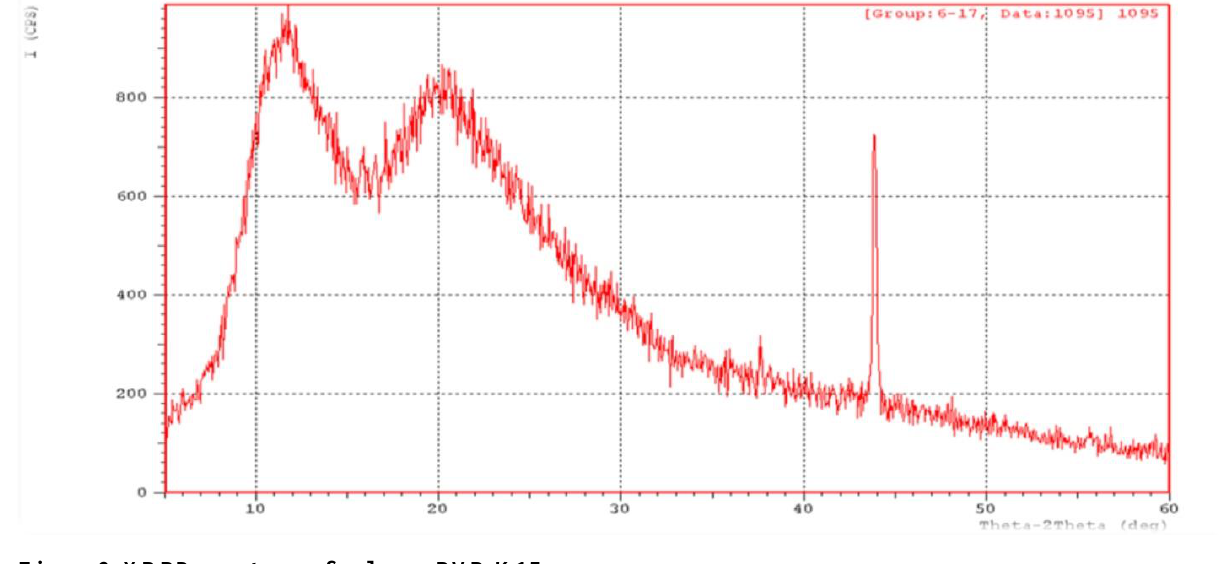
Figure 9. XRPD spectrum of polymer PVP-K15